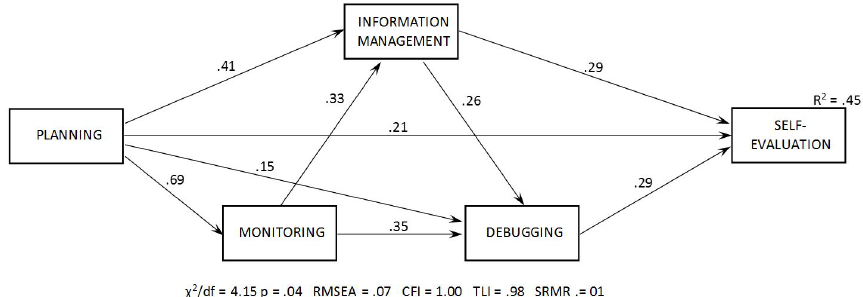
Figure 4. A model of the regulation of